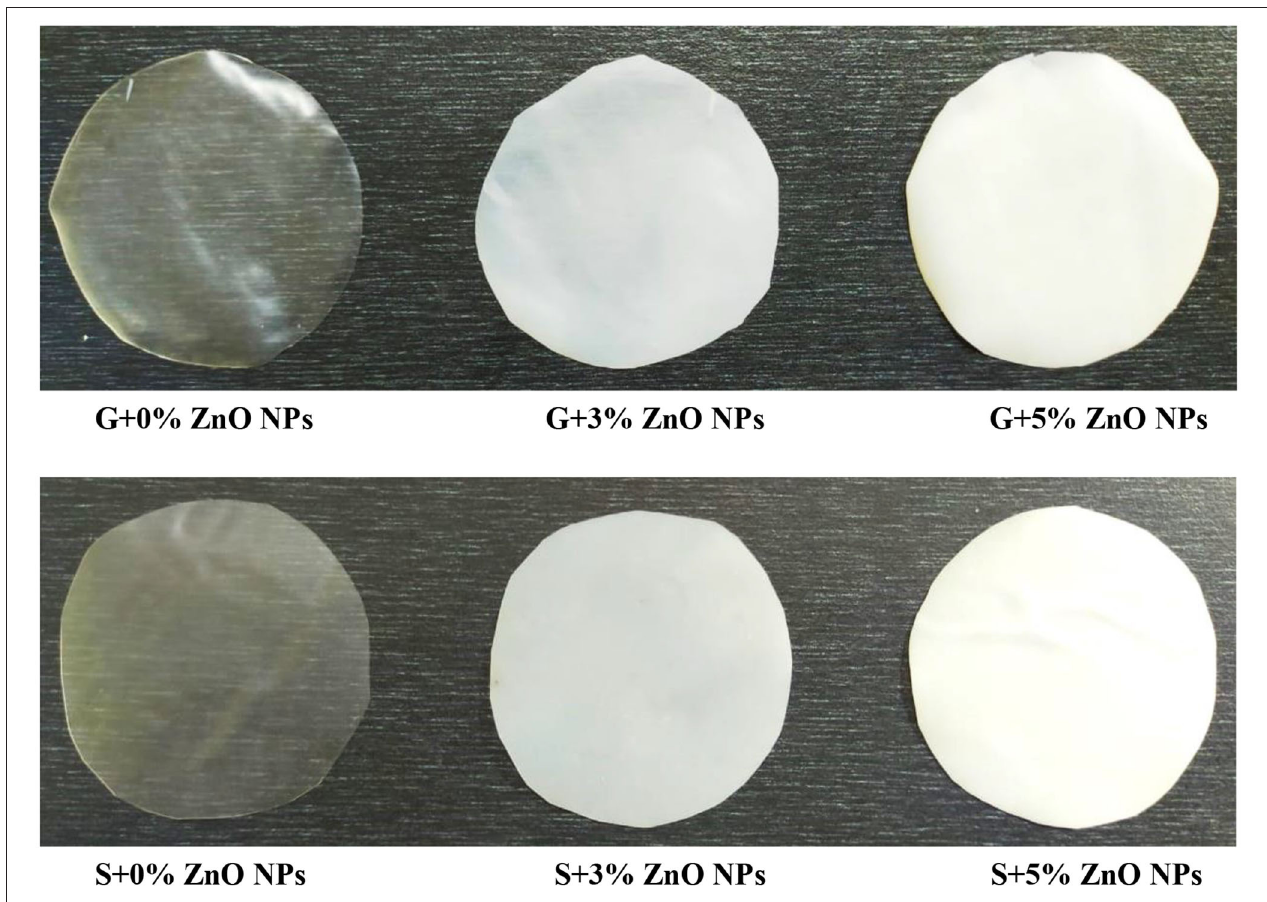
FIGURE 1 | Photographs of the bionanocomposite